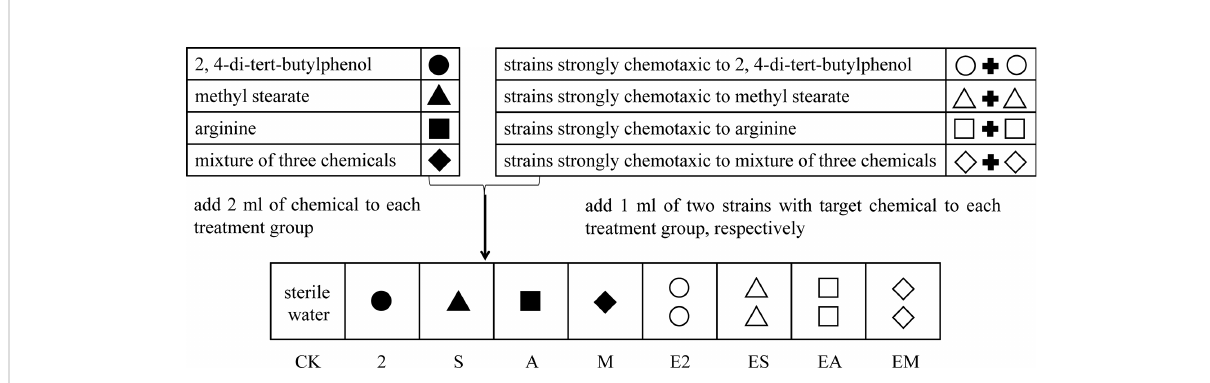
FIGURE 1 Experimental design to determine the effects of different simulated chemoattractants and chemotactic strains on bacterial community assembly in the rhizosphere soils of a C. equisetifolia